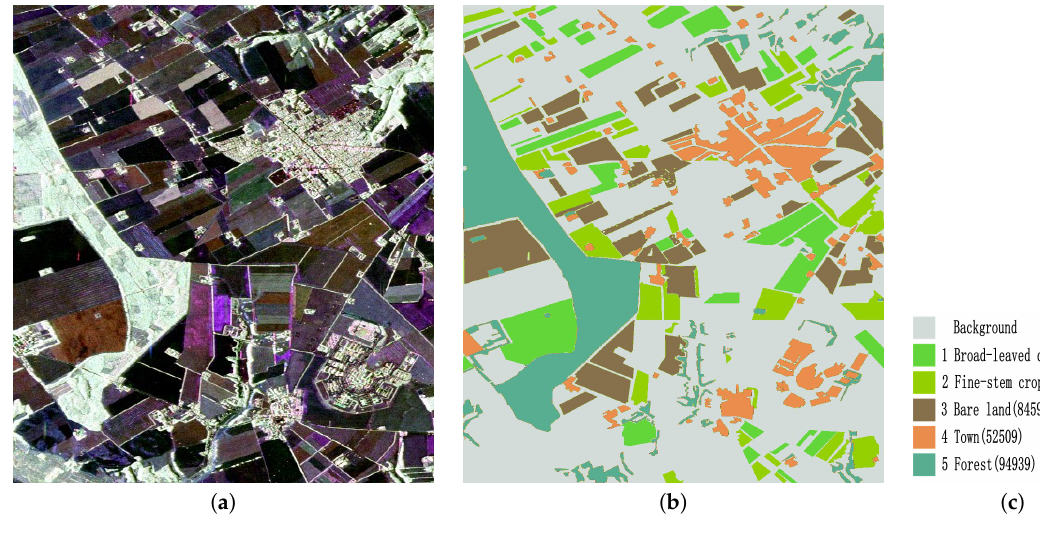
Figure 7. Foulum dataset. ( a ) Pauli RGB. ( b ) Ground Truth. ( c